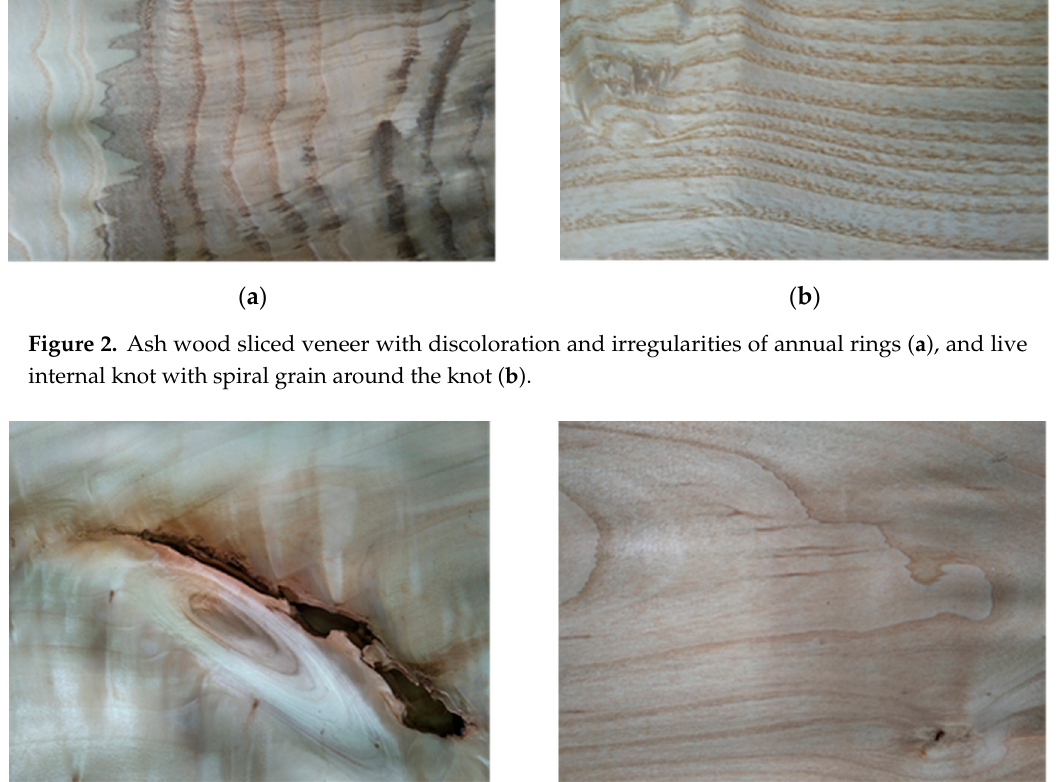
Figure 3. Poplar wood sliced plain-cut veneer sheet with live knot and decay ( a ), and cherry wood veneer with irregularities of annual rings ( b ).